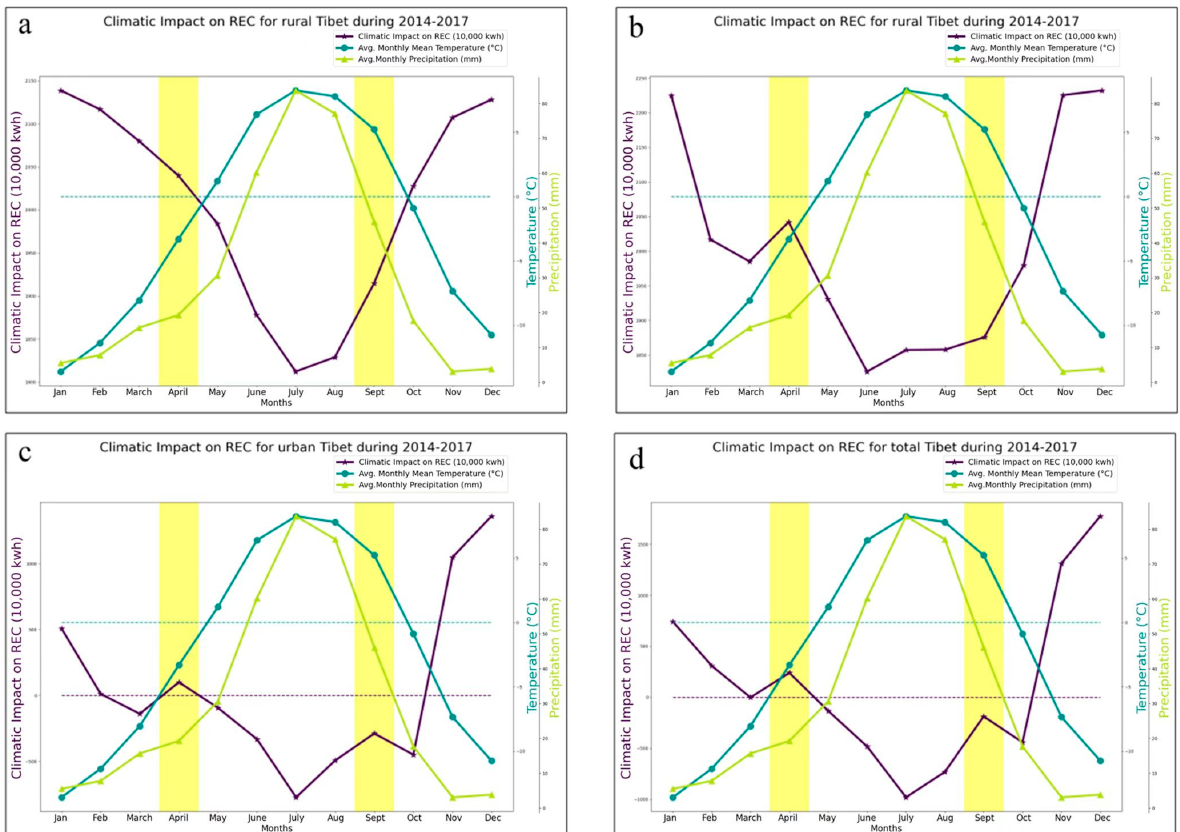
Figure 6. Effect of the climate on the REC in rural, urban, and total Tibet. All plots show the marginal effect of the climate feature in the respective model (purple curve). The temperature and precipitation averaged by the calendar month are represented by blue and green curves, respectively. Plots ( a – d ) show the results of the linear rural model, tree-based rural model, urban model, and total model, respectively.